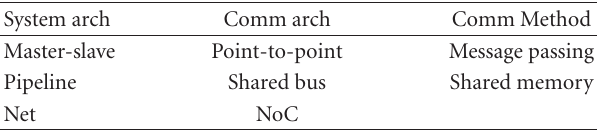
Figure 4: Shared memory multiprocessor systems. Table 2: MPSoC architecture.